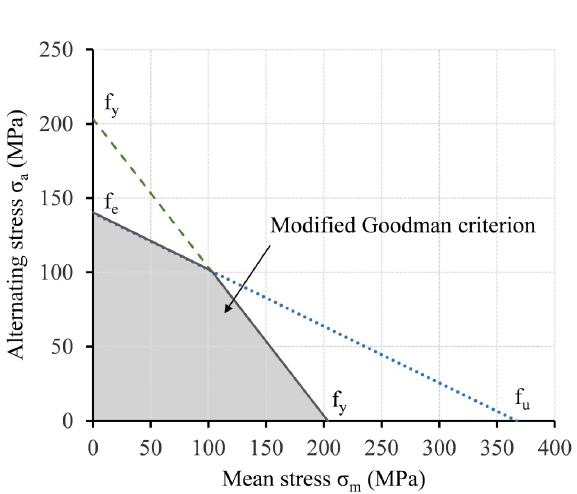
Figure 17. Modified Goodman fatigue failure criterion in a constant fatigue-life diagram.